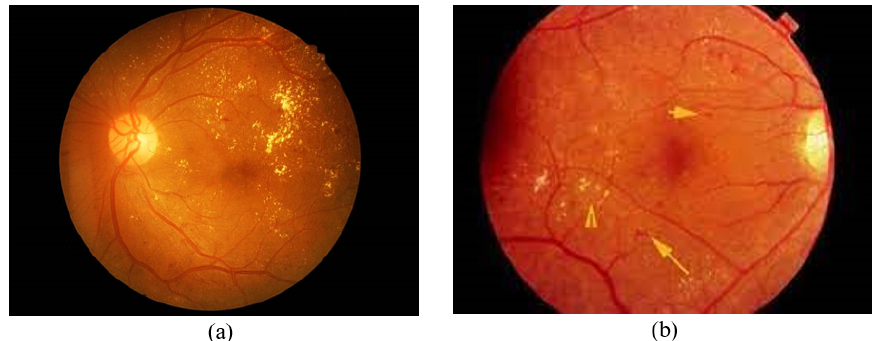
Figure 3. Diabetic Retinopathy images ( a ) DR Negative. ( b ) DR Positive.